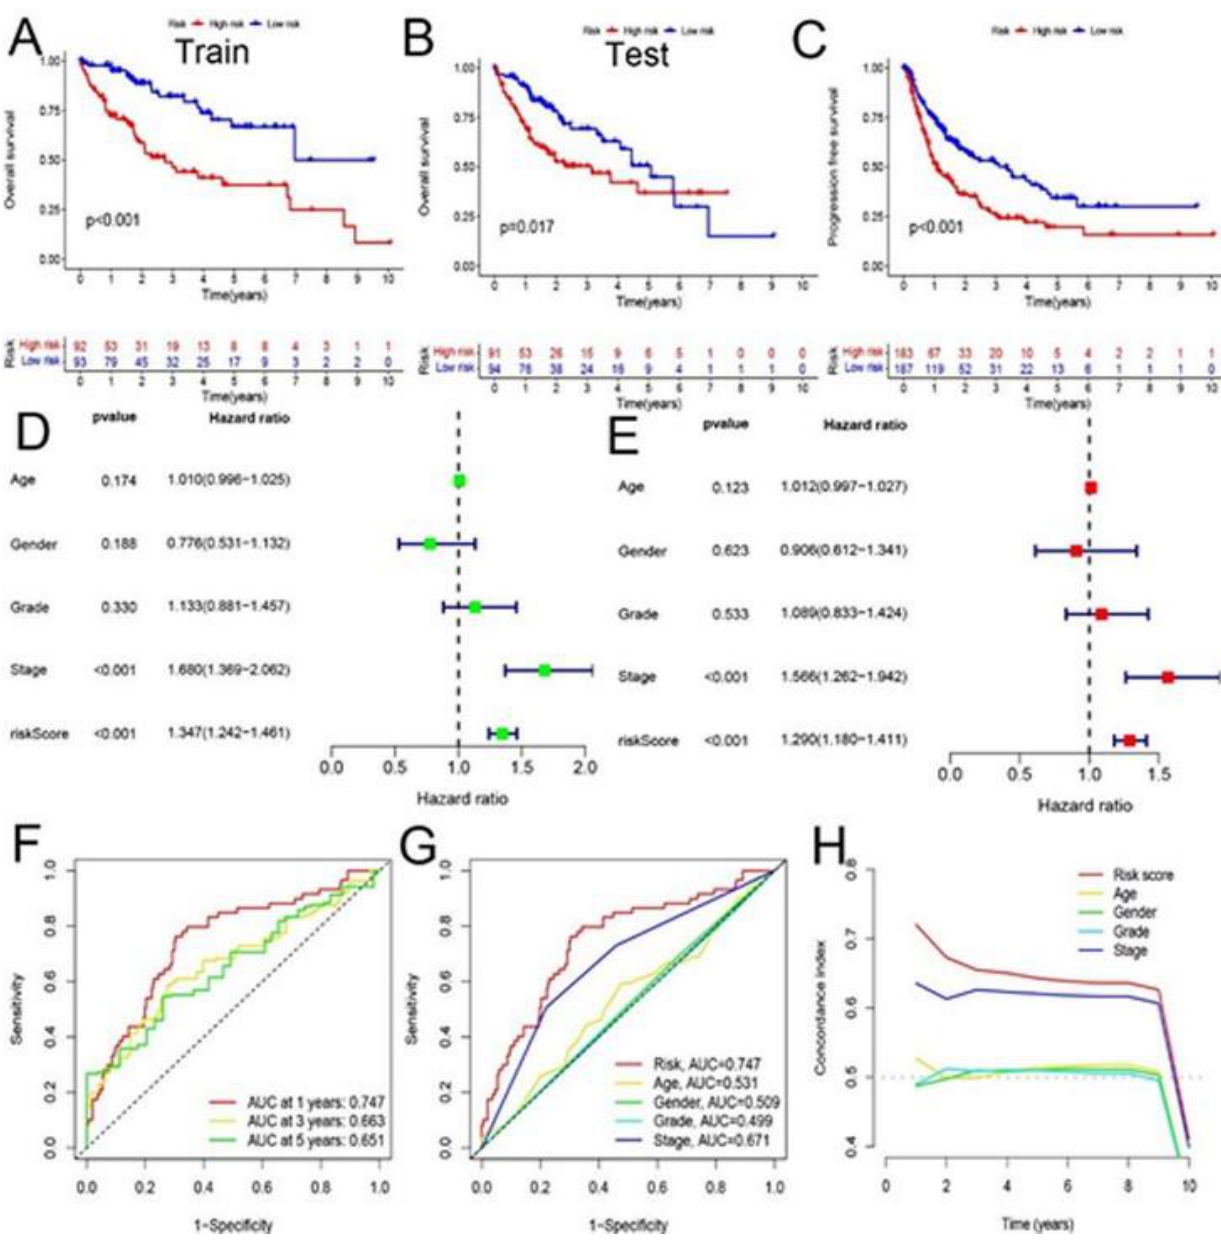
Figure 2: (A, B) Kaplan-Meier survival curves of overall survival of patients in Train and Test groups. (C) Comparison of progression-free survival between high and low risk groups. (D, E) Univariate and multivariate analyses of clinical characteristics and risk scores for survival. (F) ROC curve based on clinical characteristics and risk score. (G) ROC curve for combined analysis of clinical features and risk scores. (H) C-index curve based on risk score and clinical